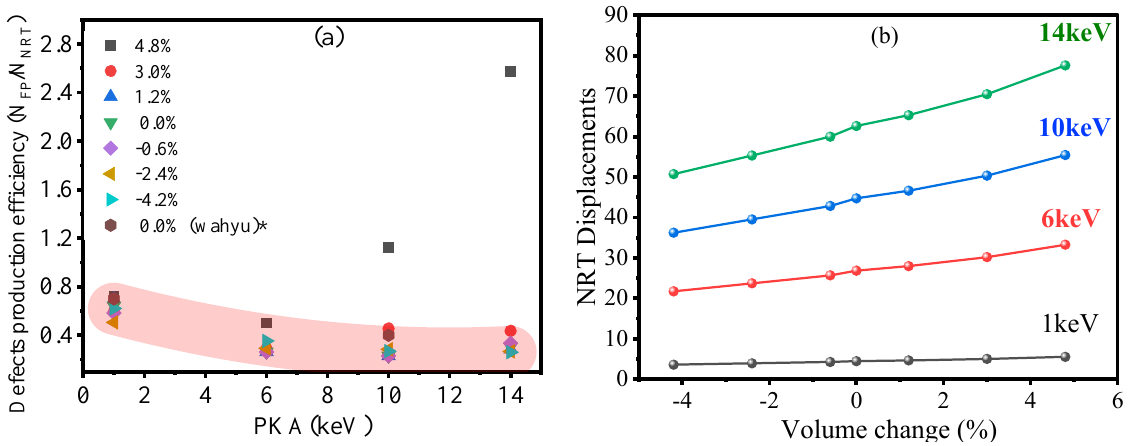
Figure 7. ( a ) Number of surviving Frenkel pairs for various PKA energies versus applied and hydrostatic strain from NRT model applications V NRT = 0.8 × E pka /2 E d,j ( ∆ V ) [45]. ( b ) The defects production efficiency which is defined as the ratio between MD and NRT result for defects calculation.